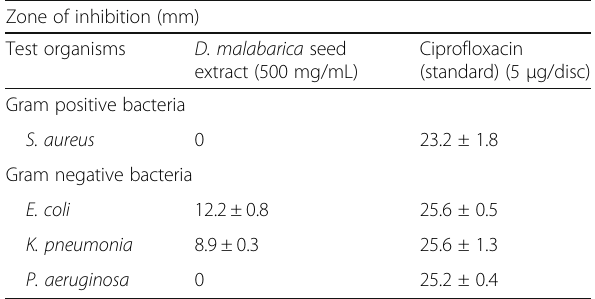
Fig. 4 Effect of the ethyl acetate extract of D. malabarica seeds on tail suspension test in